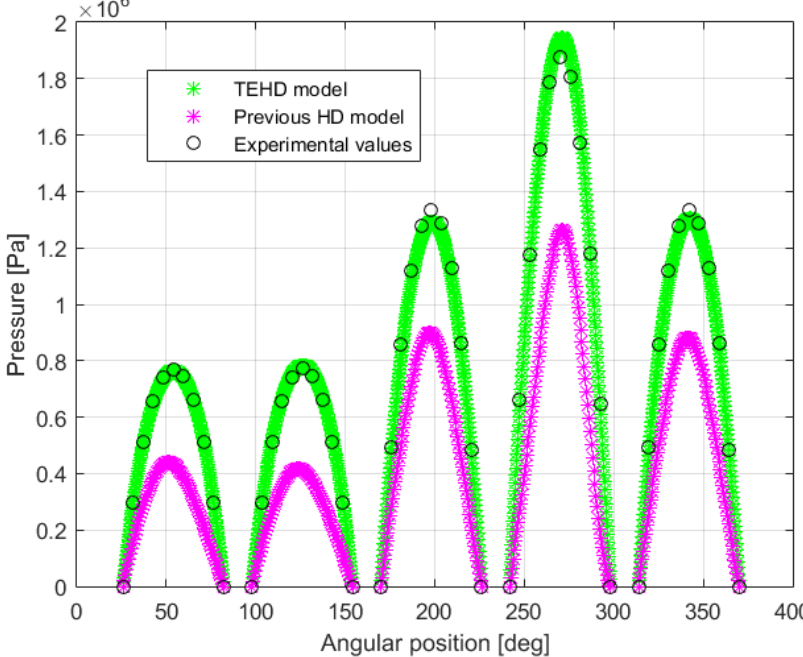
Figure 15. Comparison between the pressure field obtained with the TEHD and HD